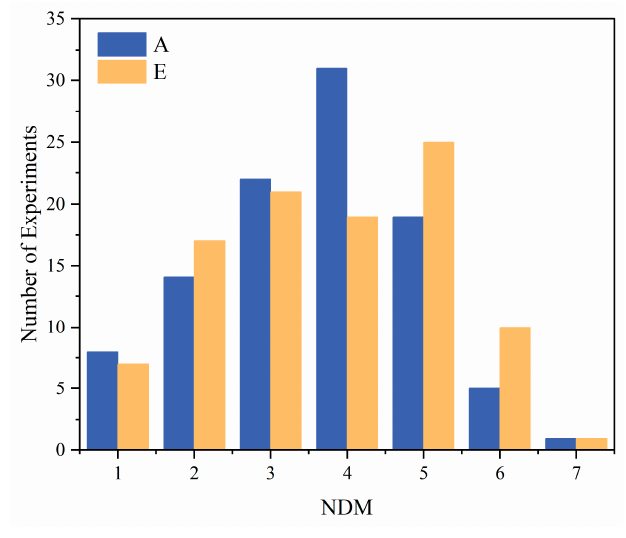
Figure 14. NDM in A and E ( t = 100). Table 7. Statistical test results for Scenario A and Scenario E